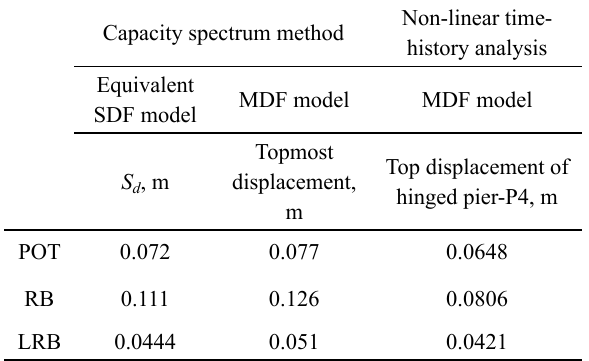
Table 7. Comparison of displacement responses of capacity spectrum and nonlinear time-history analysis Capacity spectrum